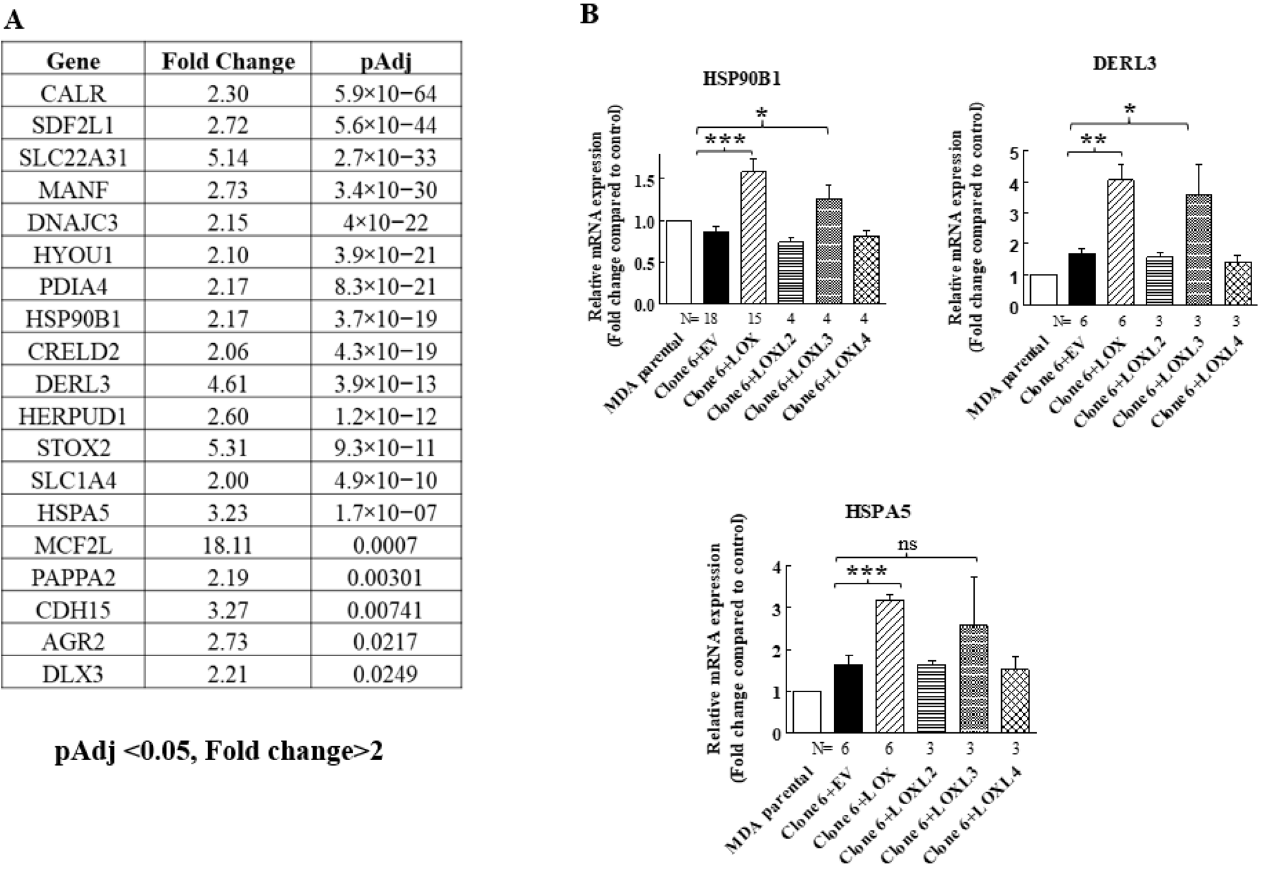
Figure 4. LOX expression in MB-MDA-231 5× knock-out cells resulted in the upregulation of the expression of the HSP90B1, DERL3 and HSPA5 genes. ( A ) A list of genes whose expression was significantly upregulated in an RNAseq screen following LOX re-expression in three different MB-MDA-231 5× knock-out clones. Listed are the genes whose expression was enhanced at least twofold and whose adjusted p values were lower than 0.05 following LOX re-expression. ( B ) The expression levels of HSP90B1, DERL3 and HSPA5 were determined using qRT-PCR in MB-MDA-231 clone 6 5× knock-out cells before and after re-expression of the indicated lysyl-oxidases. Results were normalized in comparison to the expression levels of the genes in parental MDA-MB-231 cells. Data represent the mean ± SEM of N independent experiments. Statistical significance was evaluated using unpaired student’s t test with Welch’s correction. * p < 0.05, ** p < 0.01, *** p < 0.001.